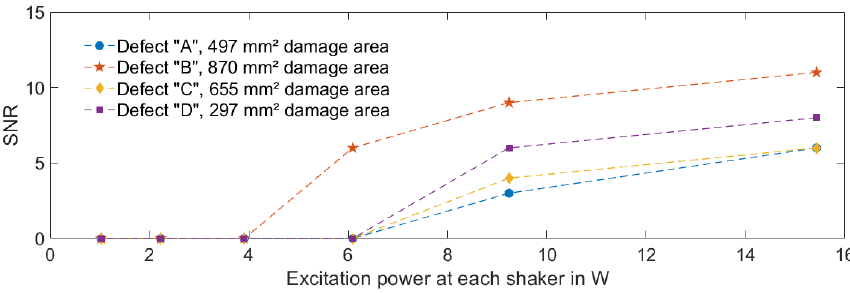
Figure 8. Signal-to-noise ratio of the defect signal depending on the excitation power at a 18–25kHz frequency sweep.